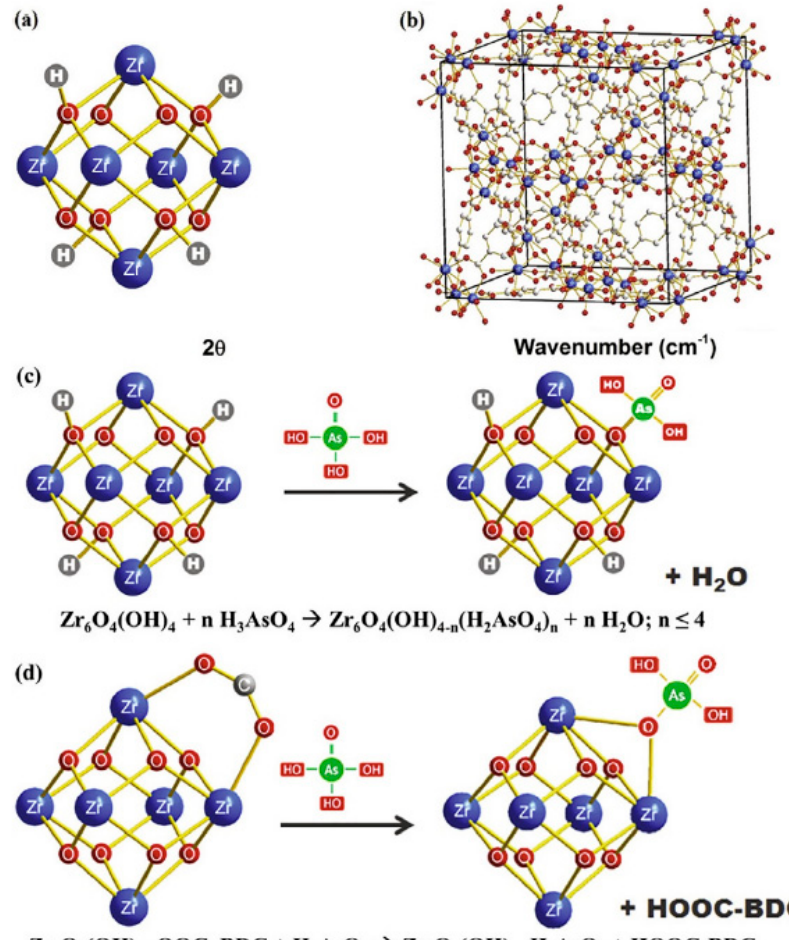
Figure 2. UiO-66 framework ( a ) with octahedral zirconium clusters ( b ), and method of adsorption of arsenate by either coordination at hydroxyl group sites ( c ) or by replacement of BDC ligands ( d ). (Reproduced with permission from Ref. [55] from Elsevier,